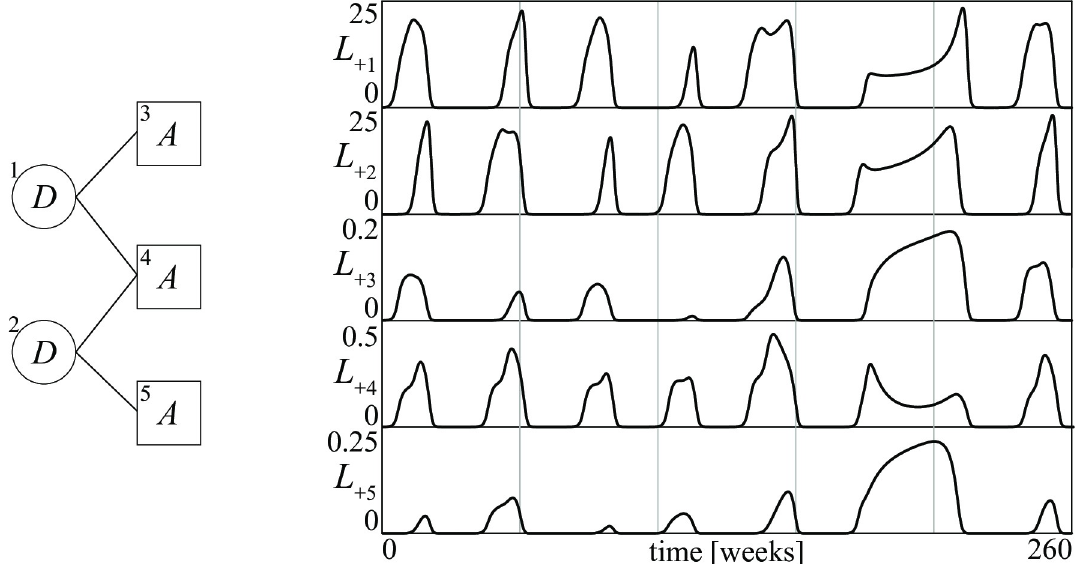
Fig 18. A conflict between five groups ( a ), and the time patterns of the losses of its chaotic stalemate ( b ).